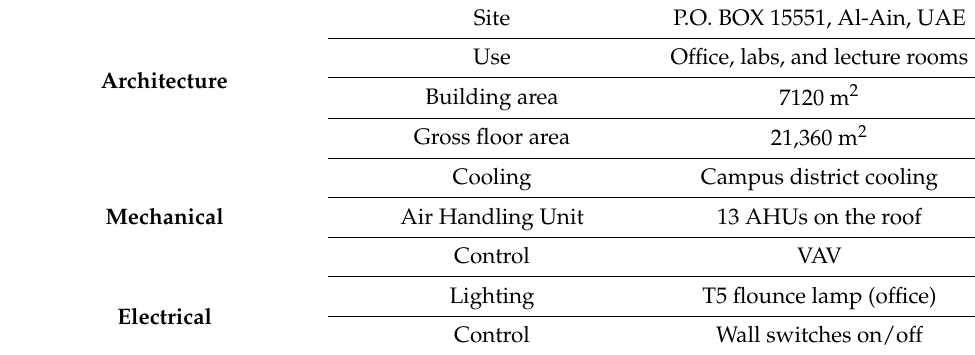
Table 3. Case study building information.